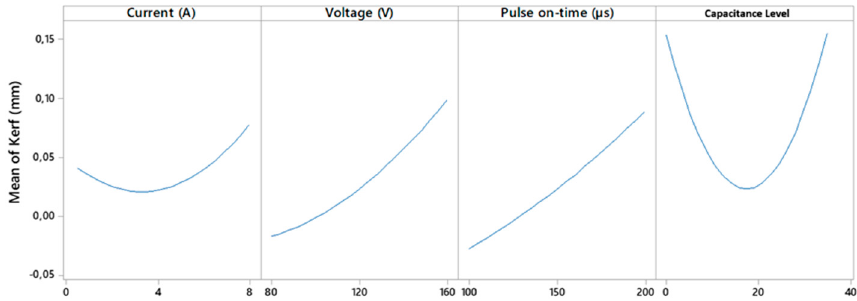
Figure 13. Individual influence of machining parameters on taper results.